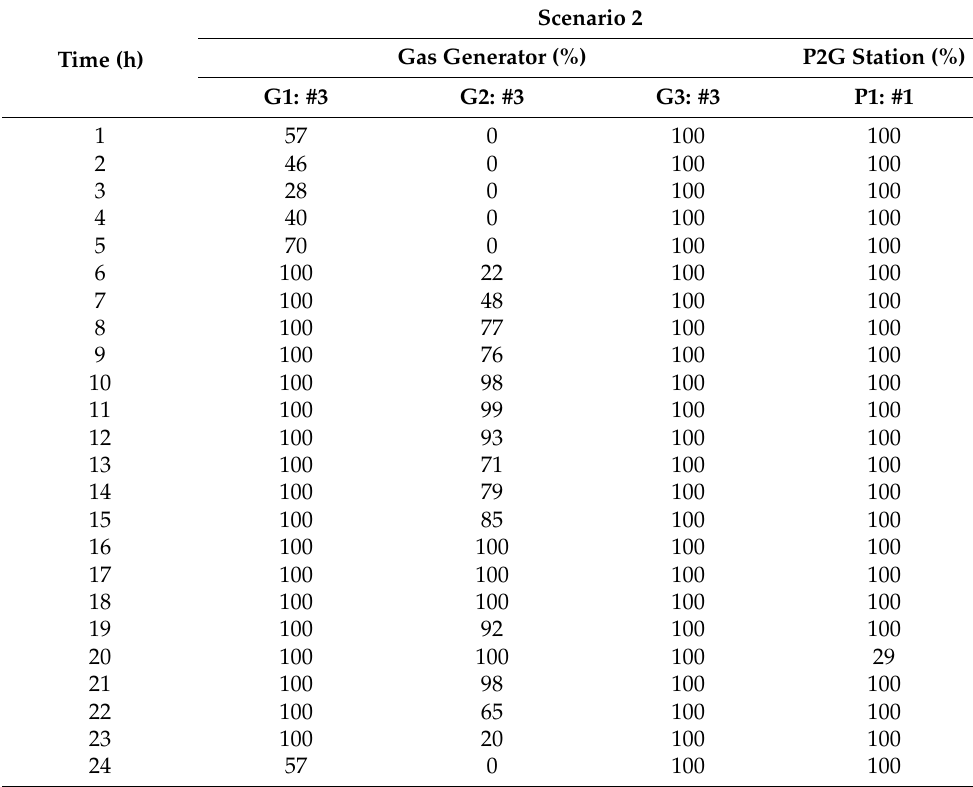
Table A8. Hourly output of gas-fired generators and P2G plants in Scenario